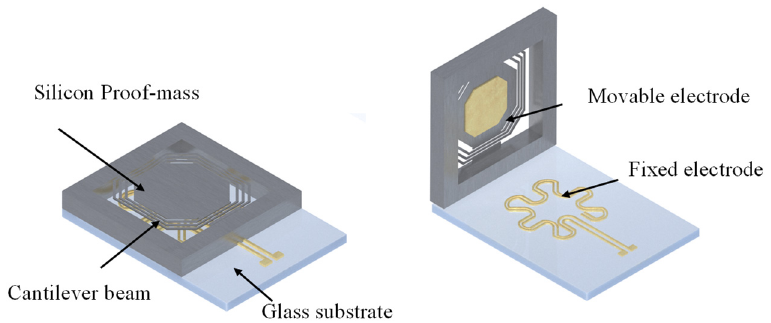
Figure 1. Diagrammatic structure of the resonant acceleration switch.